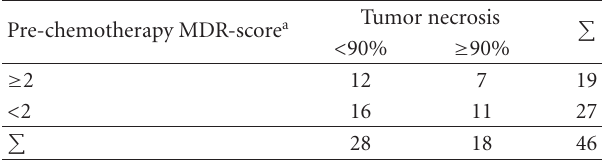
Table 6: Relationships between multiple drug resistance (Pgp expression) in pre-chemotherapy biopsies of 46 osteosarcomas and histological response (necrosis) in surgical specimens a . P value b = .